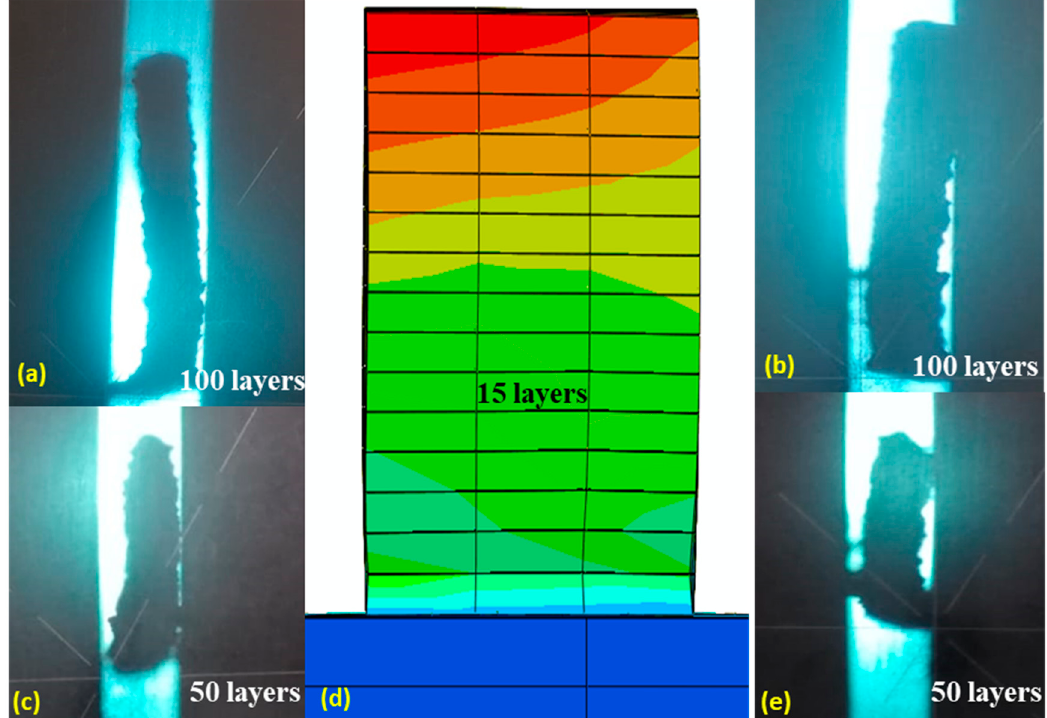
Figure 22. Comparison between current model result and measured distortion within the layers. ( a ) Left side from the front view (100 layers). ( b ) Right side from the bottom view (100 layers). ( c ) Left side from the front view (50 layers). ( d ) The distortion in the current model result ( e ) Right side from the bottom view (50 layers).